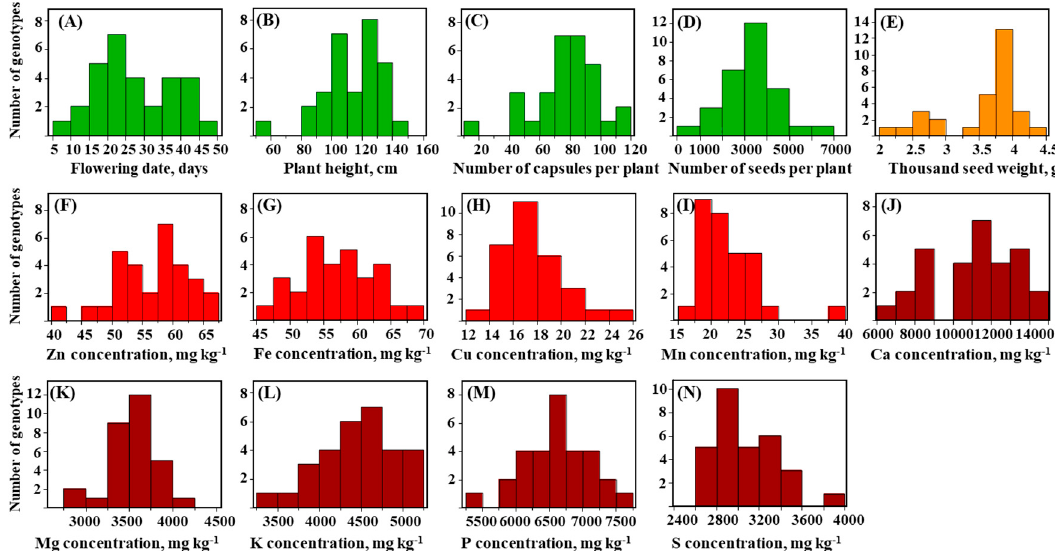
Figure 1. Frequency distribution of plant phenological and morphological traits (green): ( A ) flowering date, ( B ) plant height, ( C ) number of capsules per plant, ( D ) number of seeds per capsule, Seed quality trait (orange): ( E ) thousand seed weight and seed concentration of micronutrients (red): ( F ) zinc ( G ) iron, ( H ) copper, ( I ) manganese, and macronutrients (burgundy), ( J ) calcium, ( K ) magnesium, ( L ) potassium, ( M ) phosphorus, and ( N ) sulfur, in core-collection of 30 sesame genotypes.